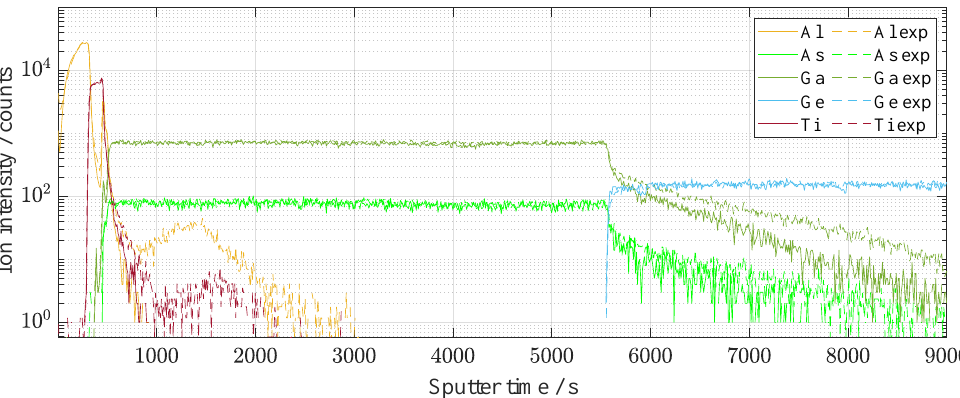
Figure 10. The whole etching process using SIMS in time dependence. The graph is in semi- logarithmic representation. The etched was exposed (illumination of 67 days, dashed line) and unexposed area. The graph is represented for a basic idea of the etching process where the etching depth was up to 8 µm. On the contrary, the second graph in Figure 11 is used to recognize the main differences in thin-films between the exposed and unexposed